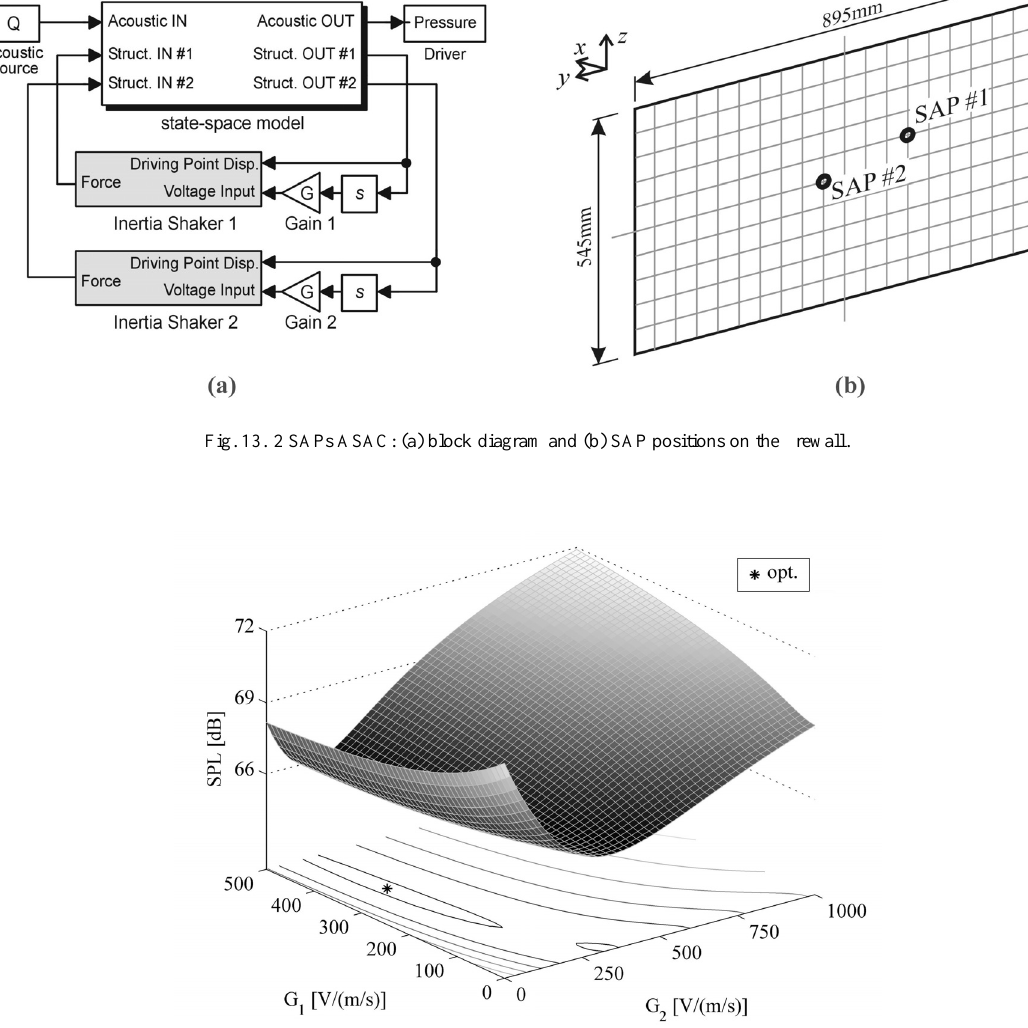
Fig. 14. Solution surface for 2 SAPs: Performance X feedback